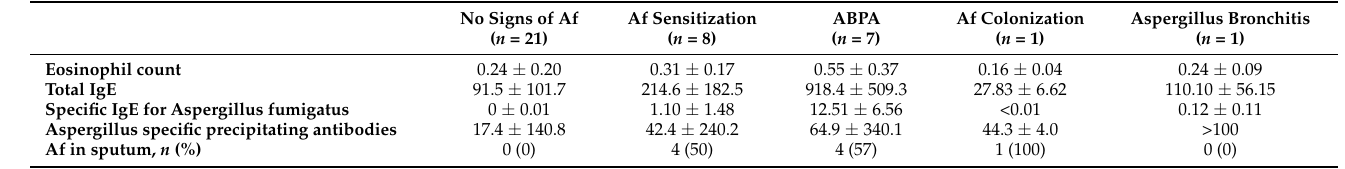
Table 2. Laboratory data of patients at time of enrollment. All values are expressed as mean ± SD.